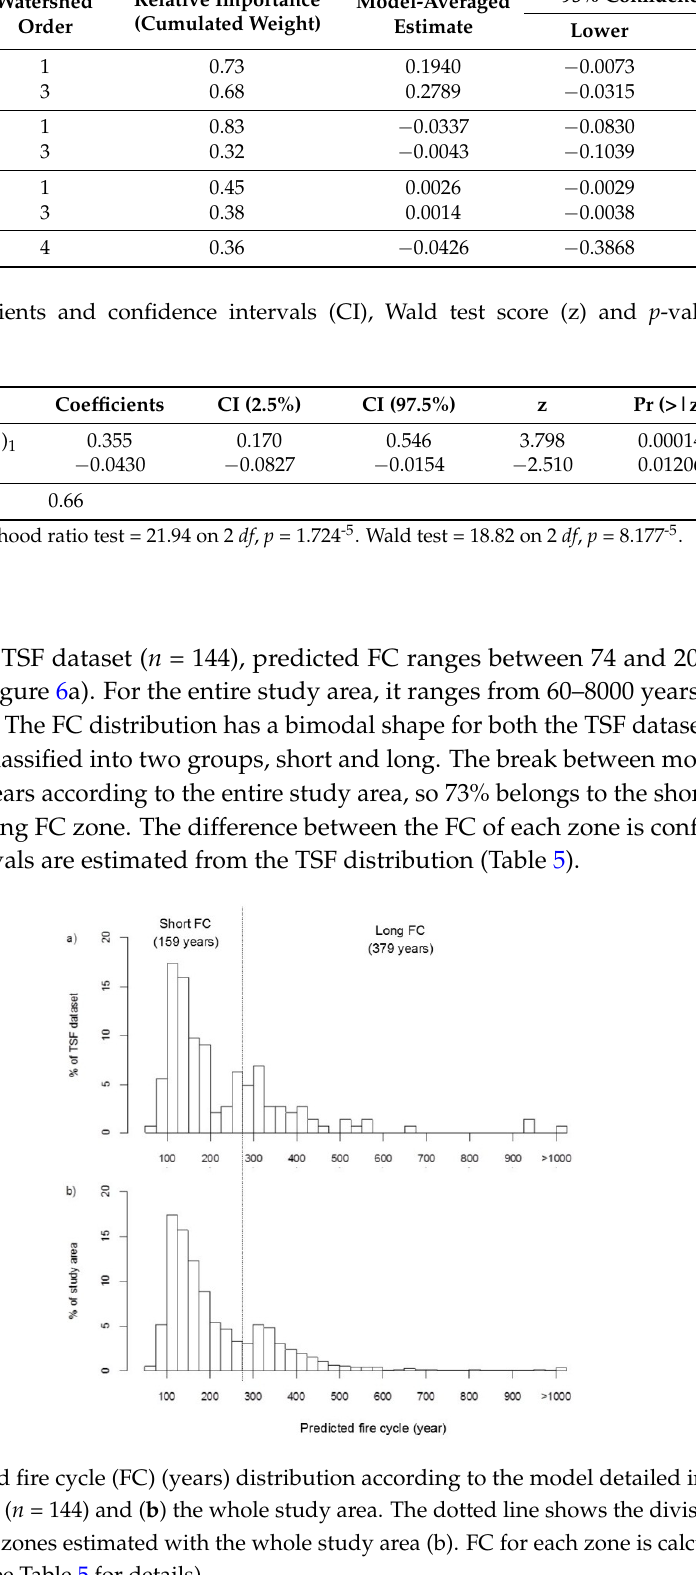
Table 3. Relative importance of parameters (cumulated weight), coefficient averaged estimate and 95% confidence interval from multi-model inference for the DRY, HD, ESD and TRI selected orders.